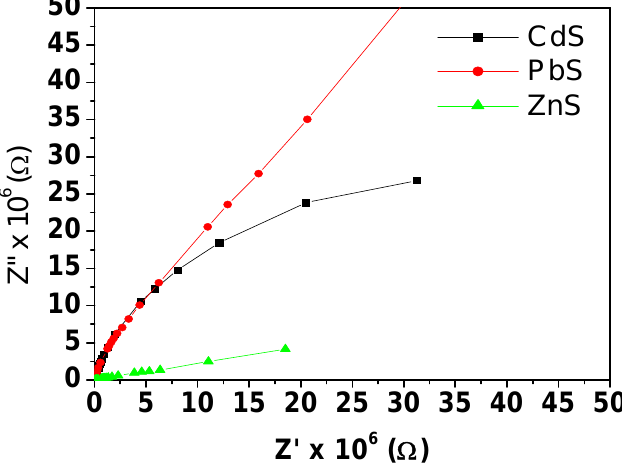
Figure 9. Cole-Cole plots of mixed conductor filled TEMPOS structures for 3% NH solution.